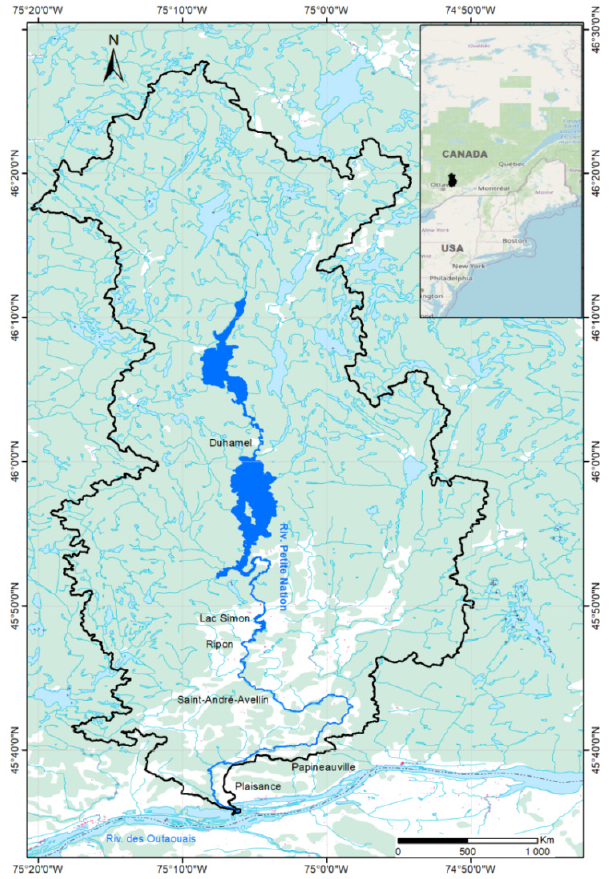
Figure 1. The Petite-Nation watershed study area.